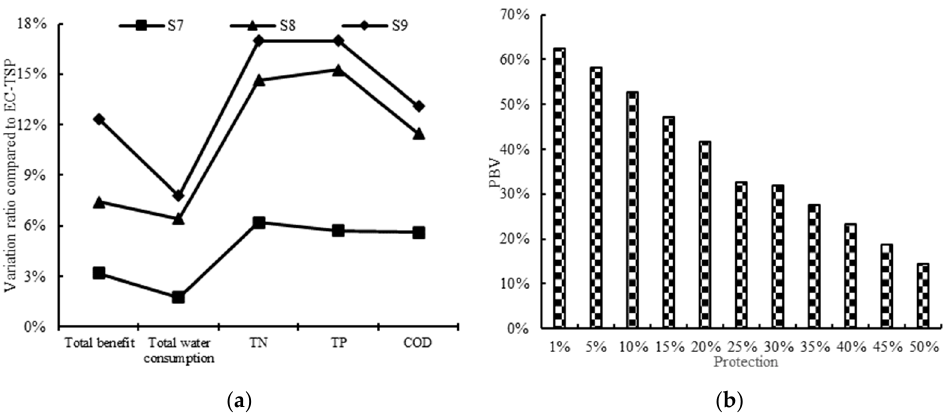
Figure 14. Model comparison and PBV risk analysis. ( a ) Comparison of EC-TSP results against EC-TSRP solutions. ( b ) Comparison of PBV risk on different protection levels.